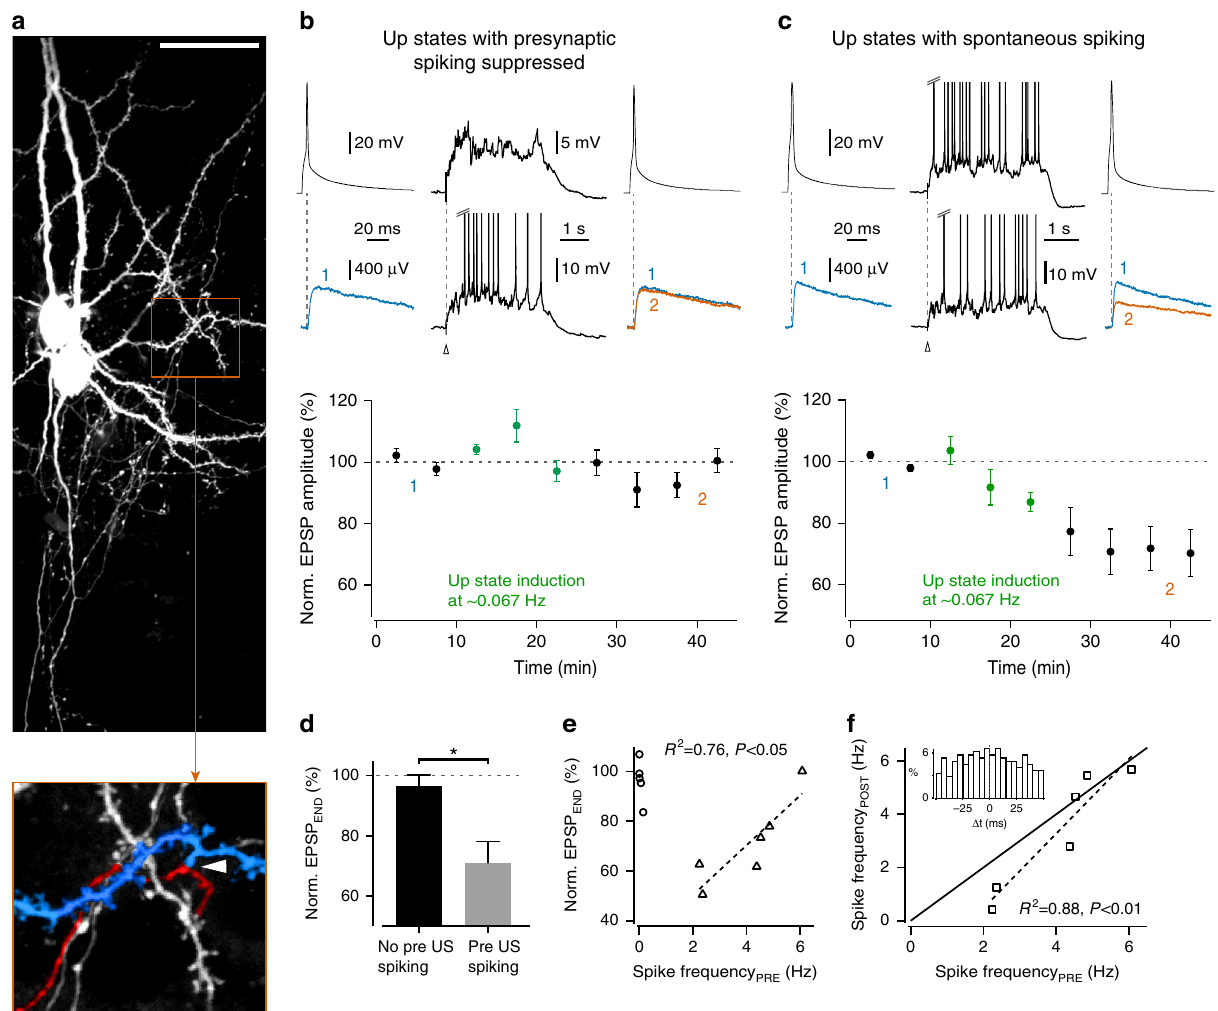
Fig. 3 Spontaneous spike patterns generated during Up states (US) induce synaptic weakening in a frequency-dependent manner. a Two-photon reconstruction of two synaptically coupled mEC LIII principal cells labeled with biocytin. A putative synapse formed between a presynaptic axonal bouton (highlighted in red ) and a postsynaptic basal dendrite ( blue ) is indicated in the magni fi ed region below ( white arrowhead ). Scale bars : 40 μ m/10 μ m. b Presynaptic spikes were triggered by brief (3 – 5 ms) depolarizing current steps and the postsynaptic EPSP amplitudes were measured. Following the recording of a 10-min baseline, Up states were also induced once per sweep for a period of ~15 min. When necessary, a constant hyperpolarizing current injection was applied to the presynaptic neuron to keep Up state spiking activity low or absent. Top : representative traces of evoked presynaptic ( upper ) and postsynaptic ( lower ) activity, during the baseline period ( left , averages of ten traces), Up state induction ( middle ; timing of Up state induction shown with white arrowhead ), and at the recording end ( right , averages of ten traces; baseline EPSP trace included in blue for comparison). Bottom : time course of changes in normalized EPSP amplitude ( n = 5; 5 min bins). Period of Up state induction is highlighted in green , with numbers indicating the time points used to calculate the average traces. c As in b , except with presynaptic Up state depolarization suf fi cient to produce self-generated spike patterns of varying frequencies ( n = 6). d Summary statistics. * P < 0.05, unpaired t -test. e Plot of the relationship between synaptic weakening and presynaptic Up state spike rate ( circles : control group with subthreshold/sparsely spiking presynaptic Up states; triangles : group with presynaptic Up state spiking). For the group with spontaneous presynaptic Up state spiking, the degree of synaptic weakening correlated signi fi cantly with presynaptic spike rate (Pearson linear correlation test). f For the group with spontaneous presynaptic Up state spiking, there was a signi fi cant correlation between postsynaptic and presynaptic Up state spike rates ( dotted line , Pearson linear correlation test). Bold line indicates unity correlation. Inset : distribution of postsynaptic Up state spike timing relative to presynaptic activity from recording shown in c . Error bars show the SEM signi fi cantly following Up state pairing (measured as ratio of EPSP slopes; 1.35 ± 0.11 during baseline compared to 1.69 ± 0.19 following pairing; n = 7, t (6) = 2.80, P < 0.05, paired t -test; Supplementary Fig. 3d), and that the change in paired pulse ratio correlated signi fi cantly with the degree of synaptic weakening ( R 2 = 0.73, n = 7, P < 0.05; Pearson linear correlation test; Supplementary Fig. 3d). Together, these fi ndings are consistent with a presynaptic component to Up state-associated synaptic weakening. NATURE COMMUNICATIONS | 8: